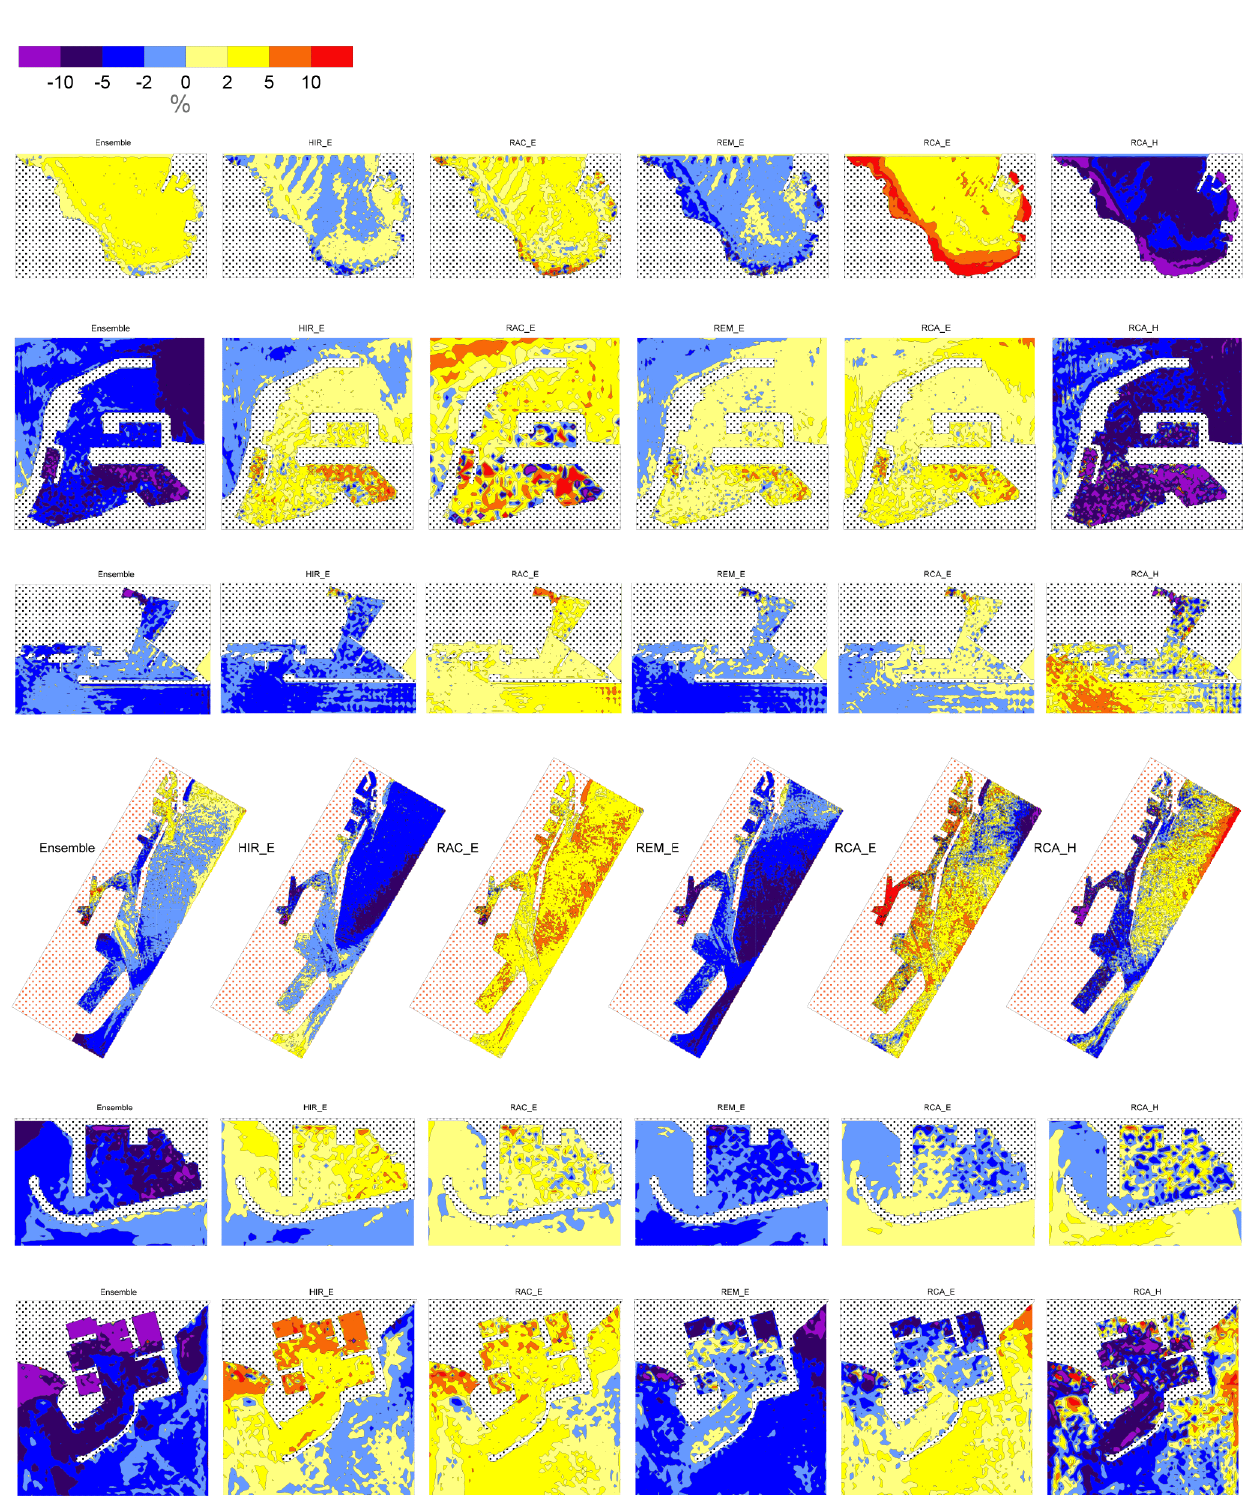
Figure 4. Projected change (future minus present in %) of H s at the studied ports presented as an ensemble of the five models and the anomalies of each model with respect to the ensemble. Panels from left to right: results for the ensemble and anomalies for HIR_E, RAC_E, REM_E, RCA_E and RCA_H models. Panels from top to bottom: Port de la Selva, Arenys de Mar, Port Fòrum, Barcelona, Garraf and Vilanova i la